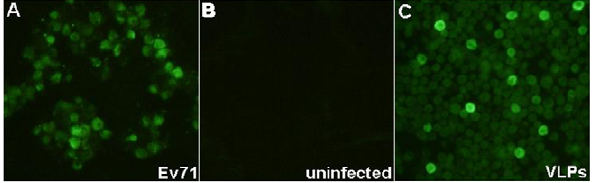
Table 2. The summary of serum samples used in the